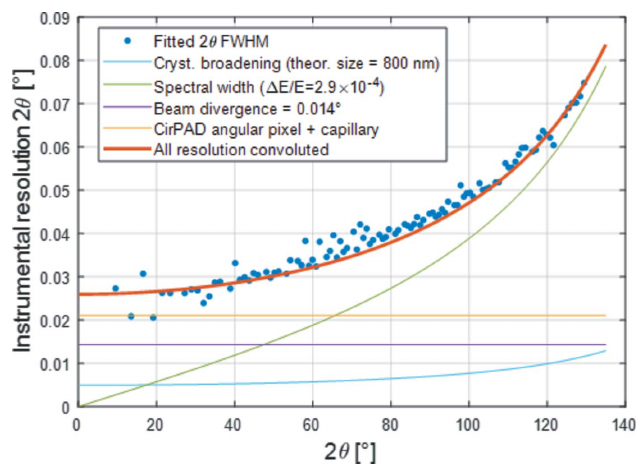
Figure 15 FWHM of the measured diffraction peaks (blue dots) deduced from the data set shown in Fig. 13. The different contributions to the peak broadening are highlighted: incident photon spectral width ( (cid:7) 3 (cid:2) 10 (cid:4) 4 , green), incident beam divergence (0.014 (cid:3) , magenta), crystallite size broadening (cyan), point spread function of the XPAD and the beam/ capillary size (orange). The modelled resolution function (red curve) is calculated as a convolution of the various